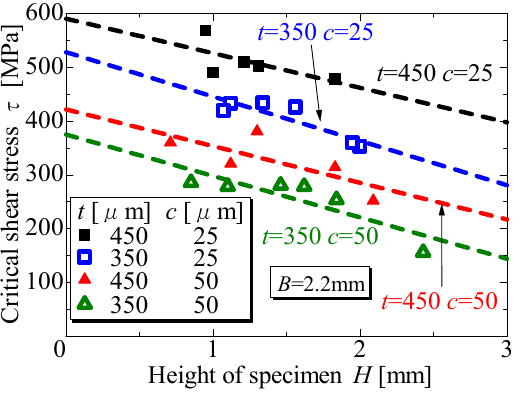
Figure 6. Influence of specimen height on failure stress for specimen width B = 2.2